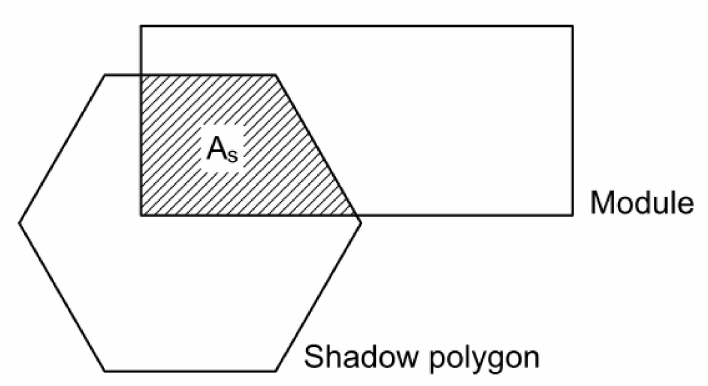
Figure 8. Area of the shadow that falls on the surface of the module. The previously calculated shadow polygon must be cropped in order to find the portion of shadow that falls on the module ( A s , hatched area).